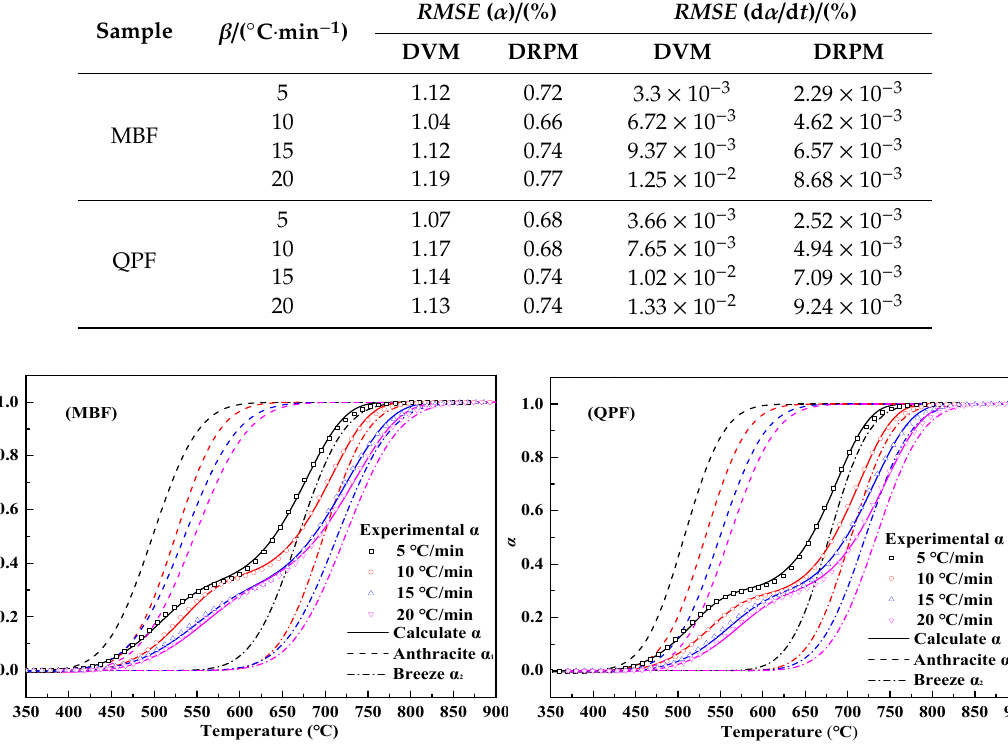
Figure 8. Comparison the correlation between experimental data and calculation results of MBF and QPF at different heating rates.